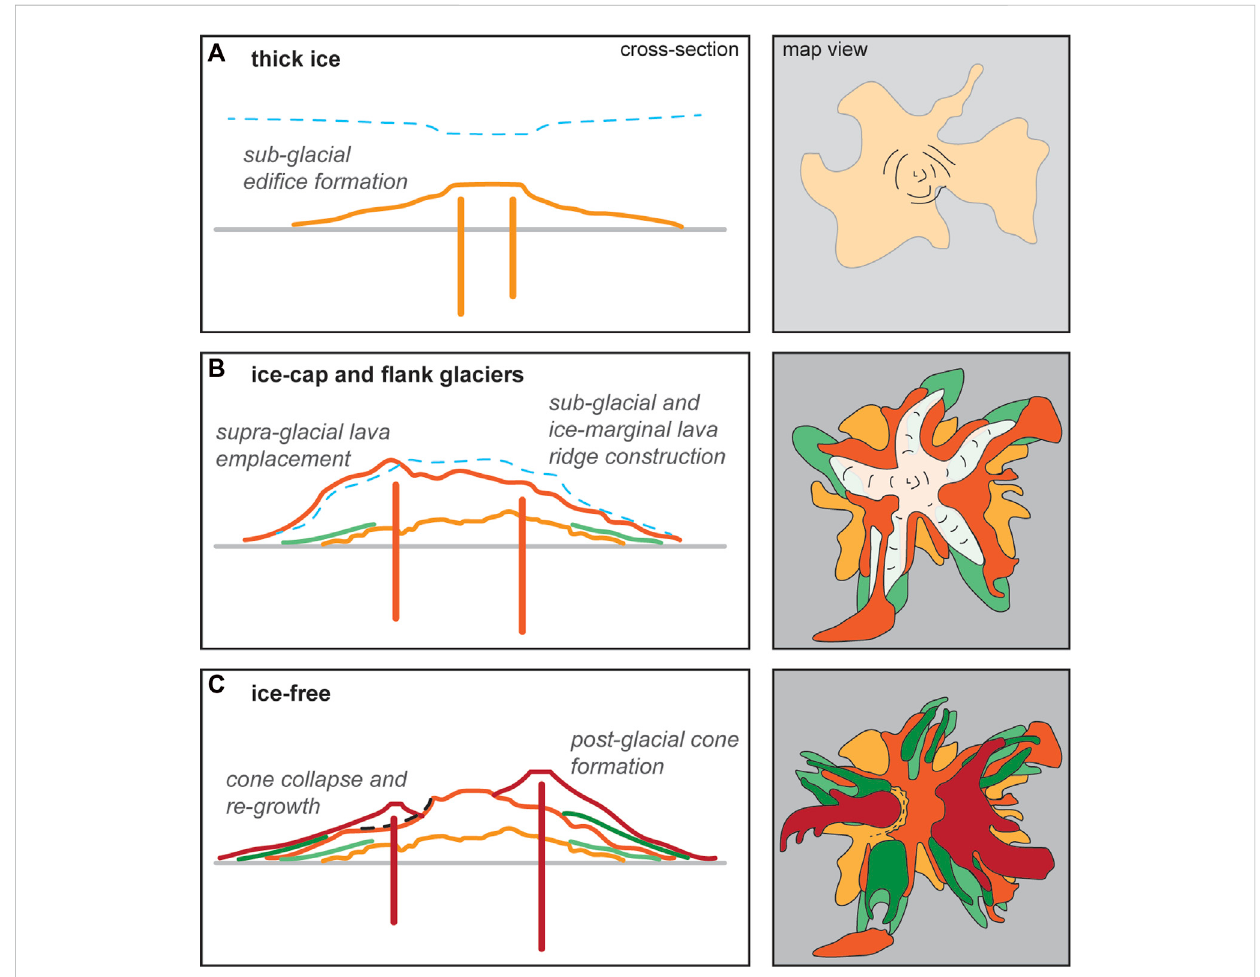
FIGURE 6 Evolution of a volcano that grew with changing ice cover over time (dashed blue line). Cross sections on the left correspond to map views on the right. (A) Tuya-likelandformdevelopsunderacontinentalicesheet. (B) Theedi fi cecontinuestogrowwithreducedicecoveragebeneathanice-capand around valley glaciers (dark orange and green units) that overlie older glacially eroded lavas [light orange units, as in panel (A) ]. Irregular and asymmetric landforms in summit areas are constructed subglacially, as shown in the cross section. Flank areas also grow where erupted materials are deposits around glaciers and onto existing fl ank bedrock (light green and dark orange units). Supra-glacial lavas are only preserved where they are emplaced on bedrock, which results in distal fl ow areas from being disconnected from high summit areas [compare the bottom-left dark orange unit between panels (B,C) ]. (C) Ice-freegrowth(darkredunits)construct ‘ perfect ’ coneventsthateruptyounglavasandpyroclasticdepositsintovacantvalleys,asalsoshown in fi eldphotos(Figures4B,E).Irregularsummitlandformsconstructedinthepresenceoficemayundergo collapse[blackdashedlineinpanel (C) ]andbe replaced by new cones [compare dark orange unit pro fi les in the cross sections of panels (B, C) ]. Glacial erosion of older units may excavate valley- fl oor units and widen valleys [compare light and dark green units between panels (B, C)